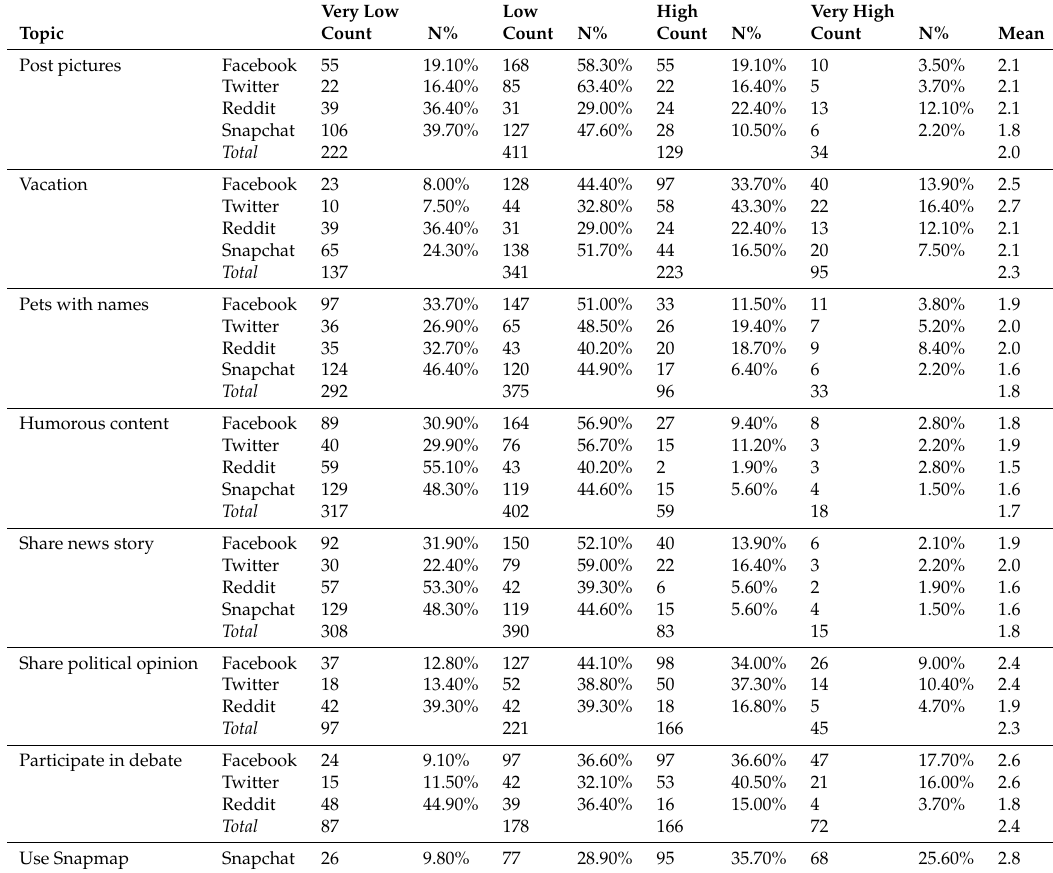
Table 15. Differences in risk perception when posting various information on social